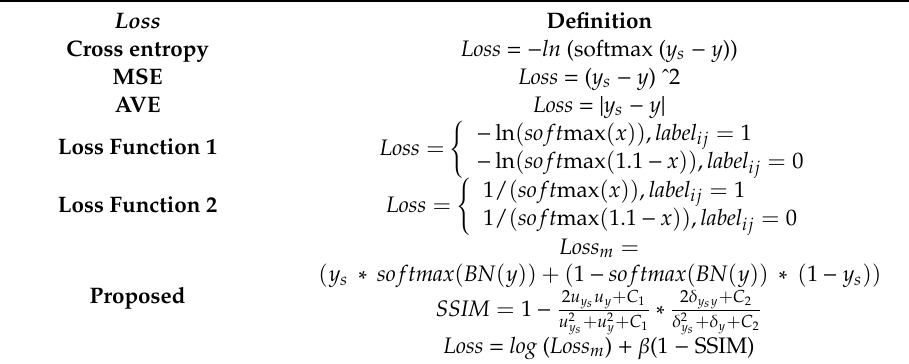
Table 4. Loss function